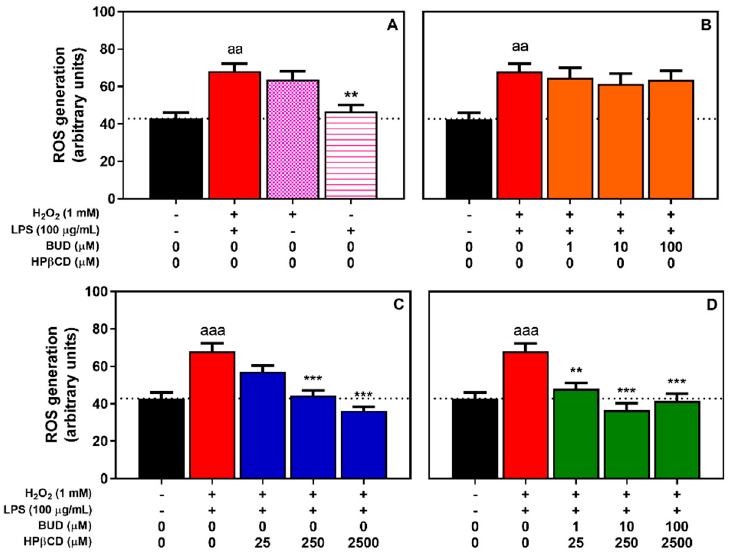
Figure 3. ROS generation in A549 cells after treatment with H 2 O 2 , LPS, or H 2 O 2 + LPS for 2 h ( A ) and e ff ect of BUD ( B ), HP β CD ( C ), and BUD:HP β CD complex ( D ) on H 2 O 2 + LPS-induced ROS generation. ROS generation was evaluated by measuring the fluorescence of dichlorofluorescein (DCF). Each bar represents the mean ± SEM of 4 independent means of triplicated measures. A one-way ANOVA with Dunett post-test was used to compare the mean of a test group with the mean of untreated group or H 2 O 2 + LPS-treated group. The di ff erence was considered significant for a p -value < 0.05. (aa), and (aaa), indicate p < 0.01, and 0.001 versus untreated group, respectively); (**), and (***), correspond to p < 0.01 and 0.001 versus H 2 O 2 + LPS-treated group, respectively.